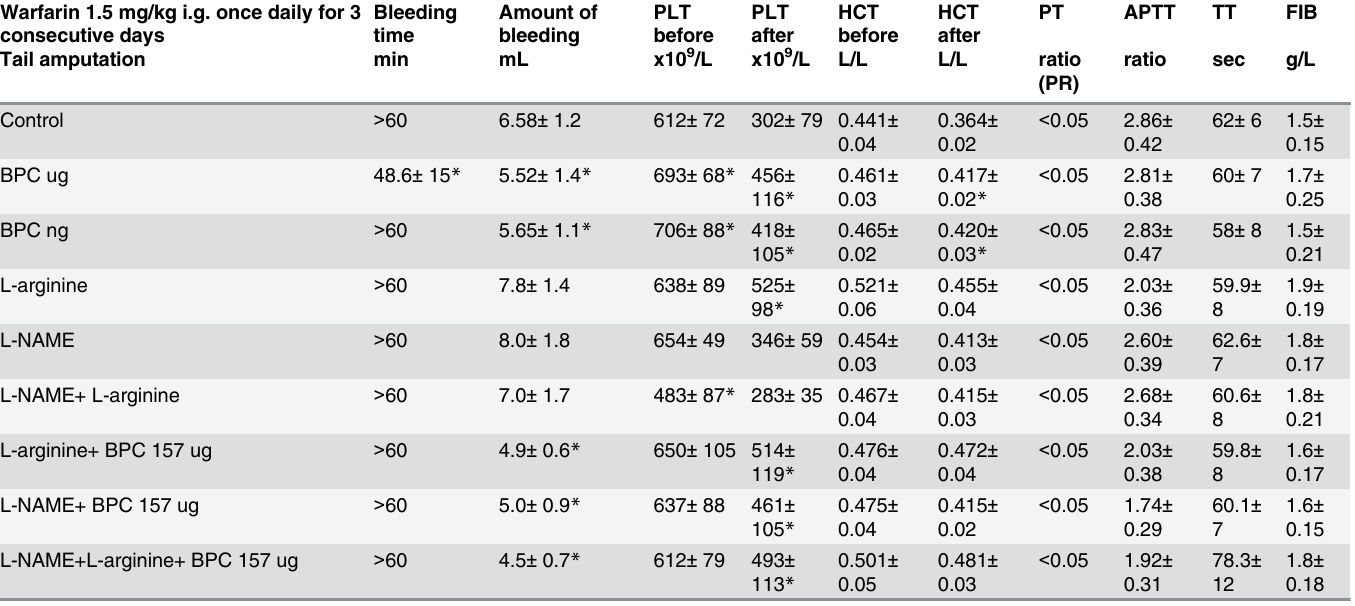
Table 4. Warfarin rats. Warfarin 1.5 mg/kg i.g. once daily for 3 consecutive